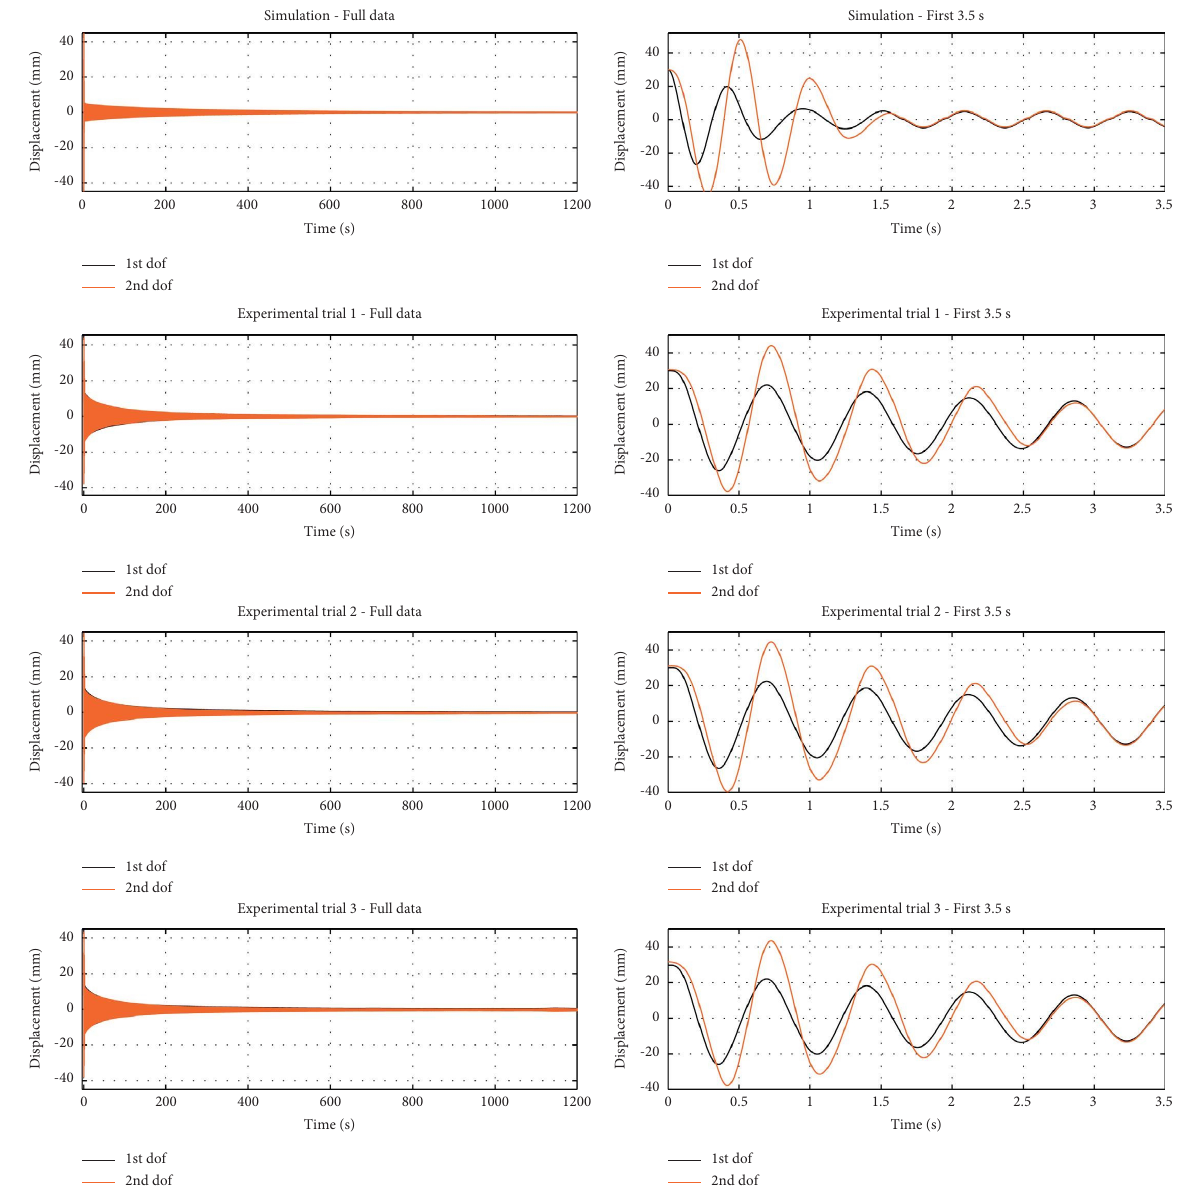
Figure 14: Real and simulated data of time response with ETMD. Tird model with